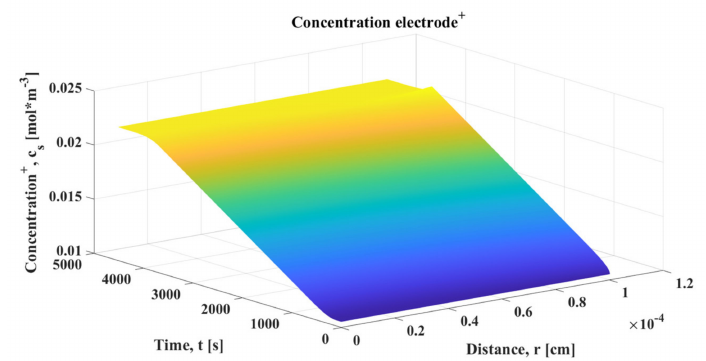
Figure 5. Concentration (Li + ) in the positive electrode of the cell (single-particle model (SPM)).